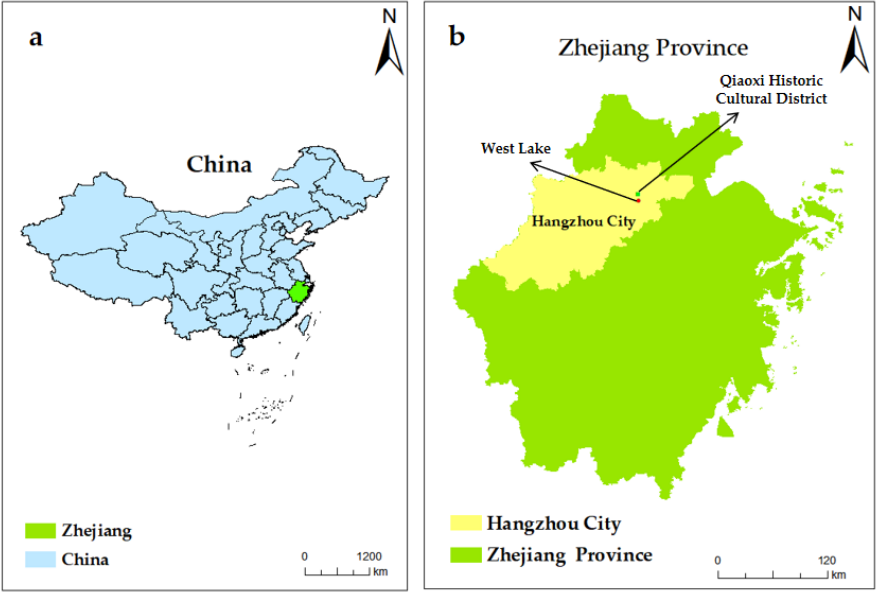
Figure 2. The geographical locations of Zhejiang Province ( a ) and two study sites in Hangzhou ( b ).